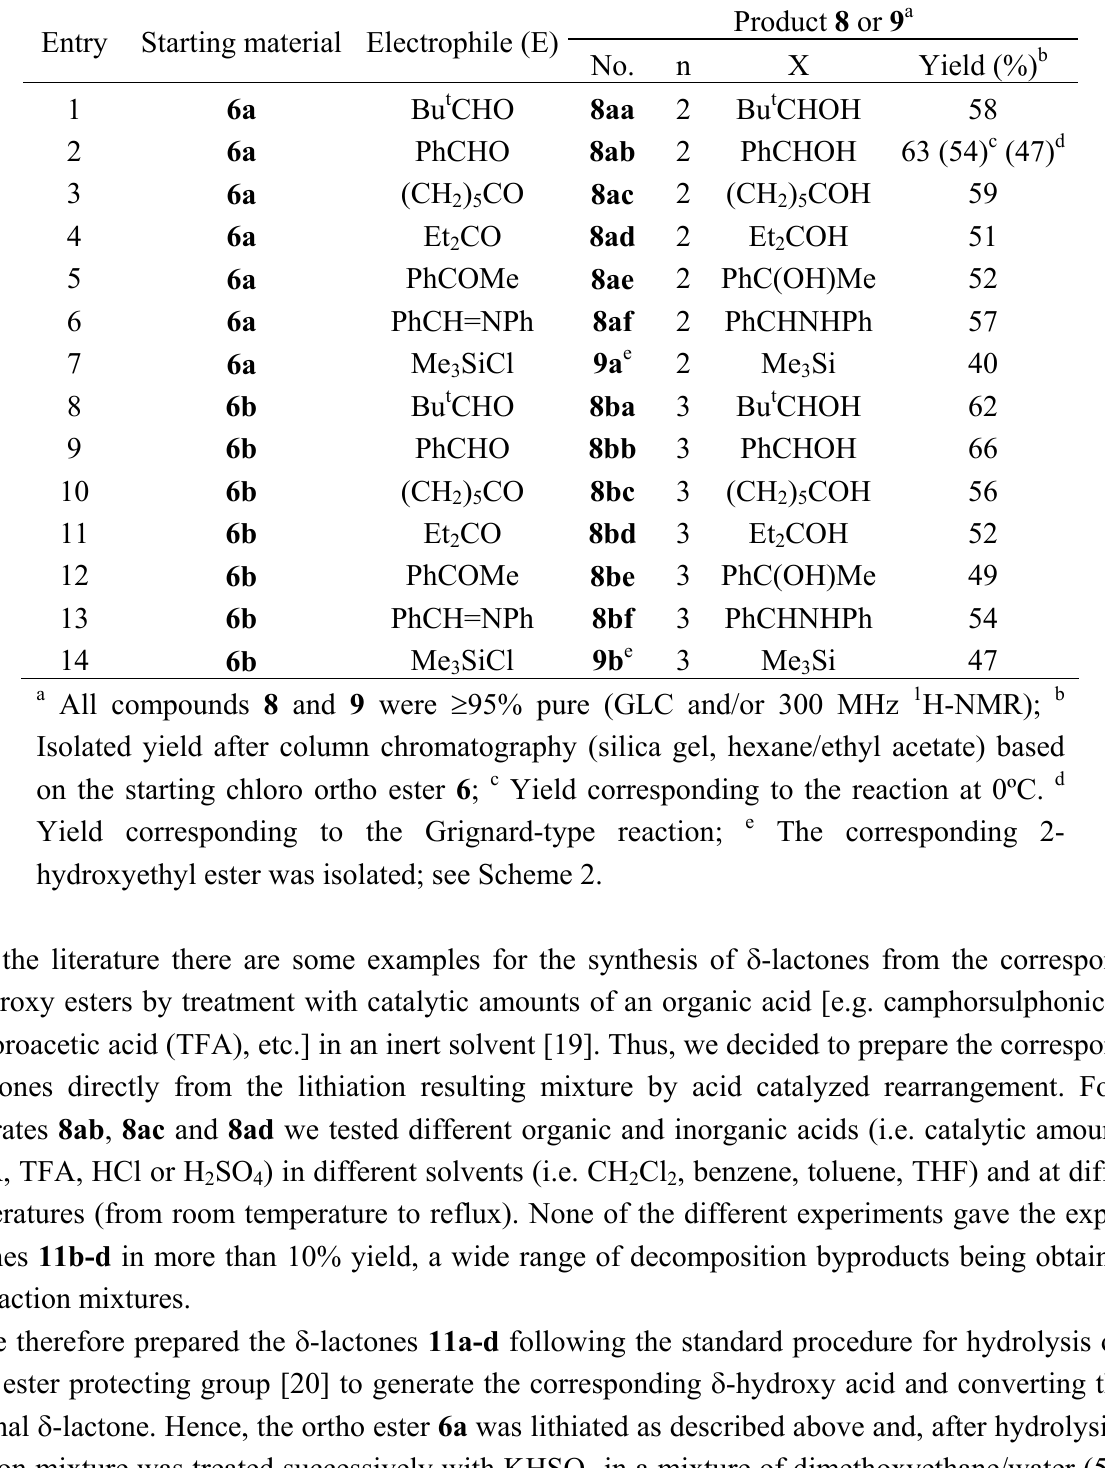
Table 1. Preparation of compounds 8 and 9 from chloro ortho esters 6 Entry Starting material Electrophile